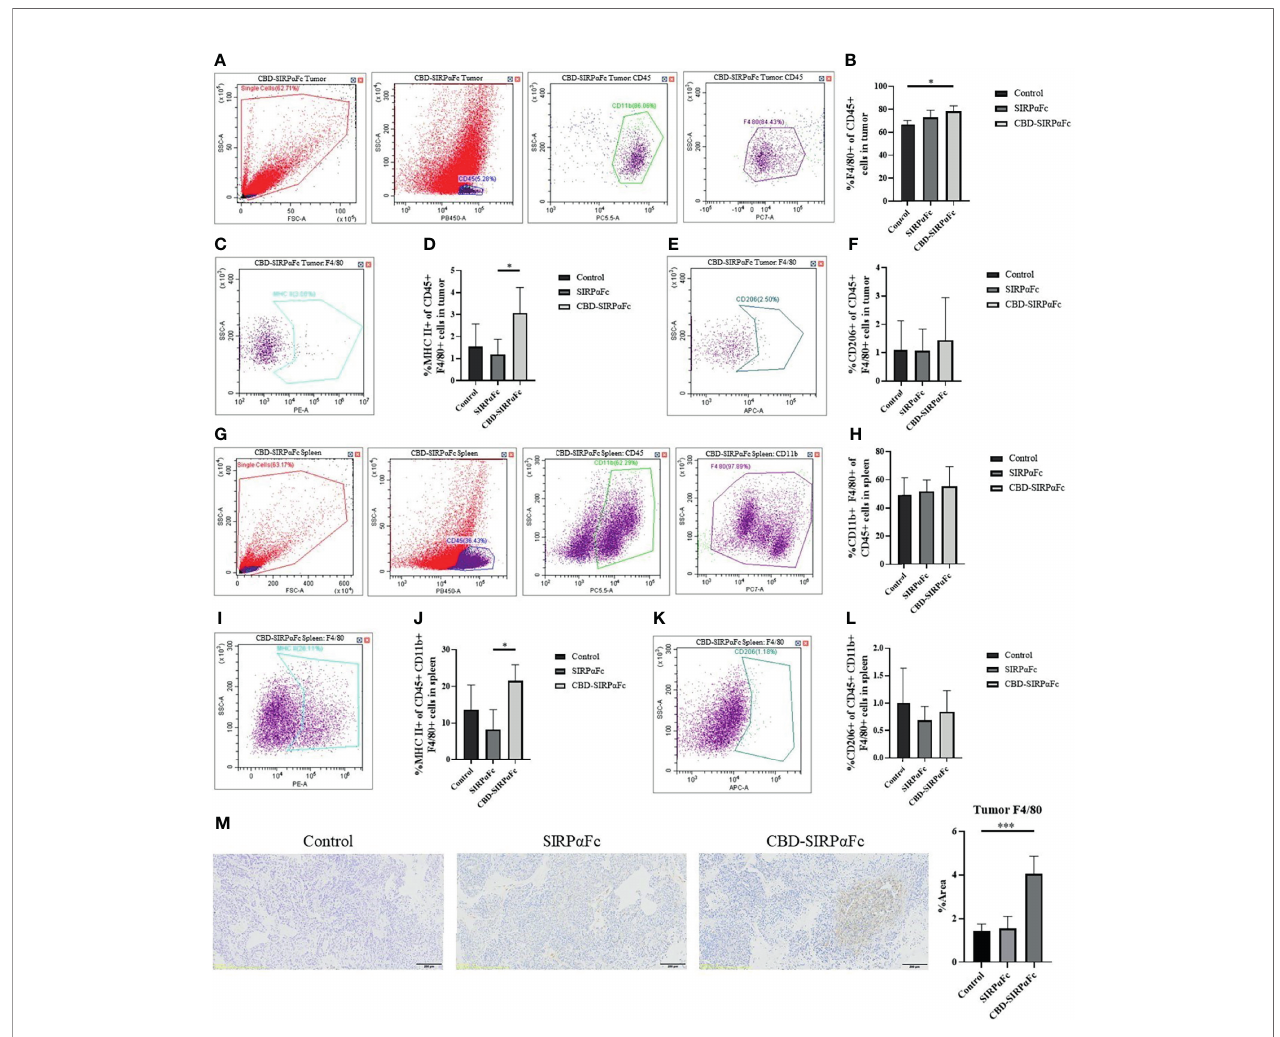
FIGURE 6 | CBD conjugation enhanced antitumor immunity. (A – L) Flow cytometry was performed to study the immune cell in fi ltration in tumors and spleens. (A – F) Macrophages in tumors were recognized by CD45 + CD11b + F4/80 + signals (A) . The percentage of F4/80 + cells in total CD45 + cells was analyzed, showing more macrophage in fi ltration in tumor in the CBD – SIRP a Fc group than the SIRP a Fc and control group (B) . M1 and M2 macrophages were also analyzed, in which MHC II + M1 macrophages (C) and CD206 + M2 macrophages (E) were labeled. MHC II+ M1 macrophages were more in the CBD – SIRP a Fc group (D) , supporting better tumor antigen presentation. M2 macrophages were maintained in all groups (F) (n = 5 for the CBD – SIRP a Fc group and n = 4 for the control group and SIRP a Fc group, mean + SD, *p < 0.3332). (G – L) Macrophages in spleen were also selected as described above (G) , and the percentage of CD11b + F4/80 + macrophages in total CD45 + cells represented the same but weaker trend as in tumor (H) . MHC II + M1 macrophages and CD206 + M2 macrophages in spleens were labeled as in tumors (I, K) . High frequency of MHC II + M1 macrophages appeared in the CBD – SIRP a Fc group (J) while CD206 + M2 macrophages still represented no signi fi cant differences (L) (n = 5 for the CBD – SIRP a Fc group and n = 4 for the control group and SIRP a Fc group, mean + SD, *p < 0.3332). (M) F4/ 80 immunohistochemistry staining was performed to help with studying the macrophage in fi ltration in tumors. F4/80 + signals appeared with a higher frequency in tumors of the CBD – SIRP a Fc group, which was coincident to the result of fl ow cytometry. Proportions of positive area were counted by ImageJ software and analyzed by one-way ANOVA in GraphPad Prism 8 software (n = 5 for CBD – SIRP a Fc and n = 4 for the control group and SIRP a Fc group, mean + SD, *** p <